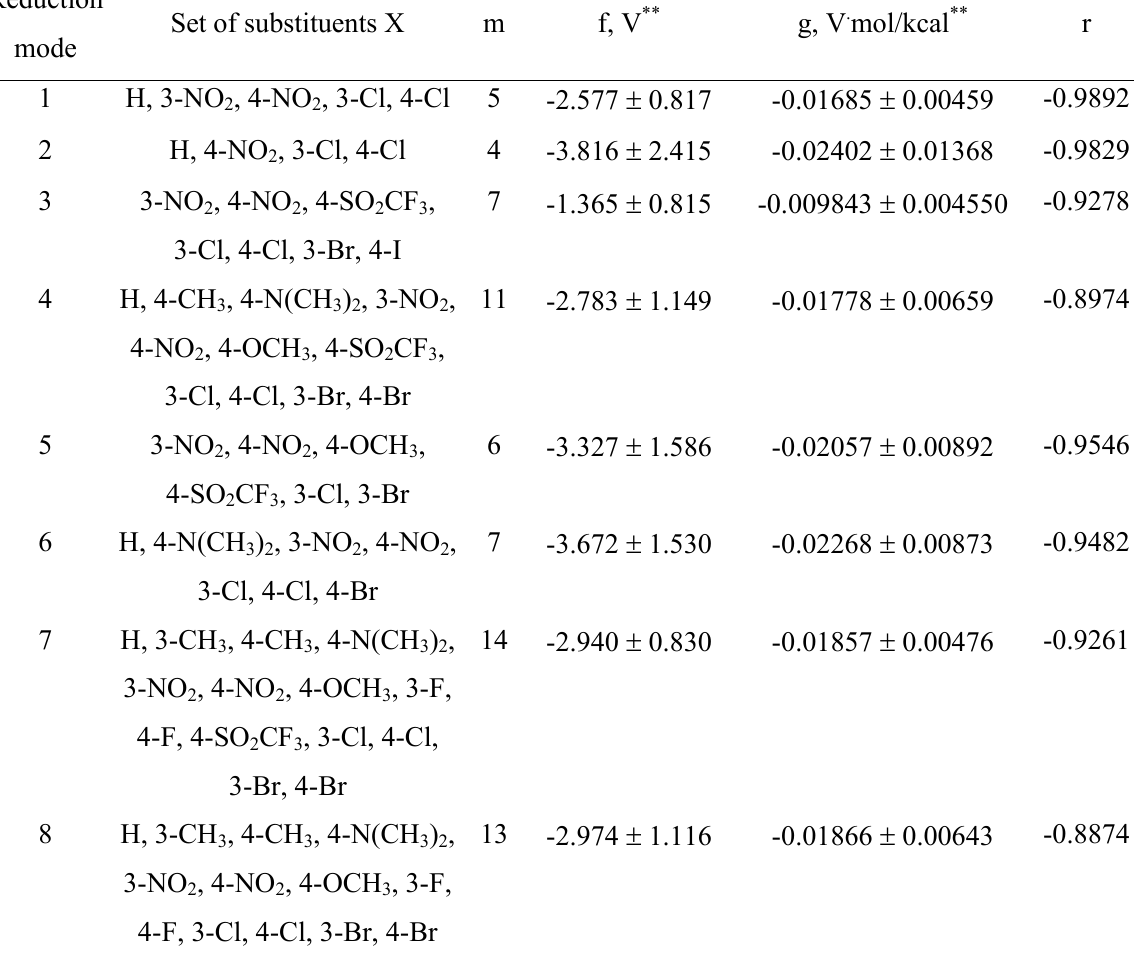
H N + ≡ N cations titration, potentials 6 4 Cl electrode) [5-7, 11], with enthalpies ( ∆∆ H 2 2